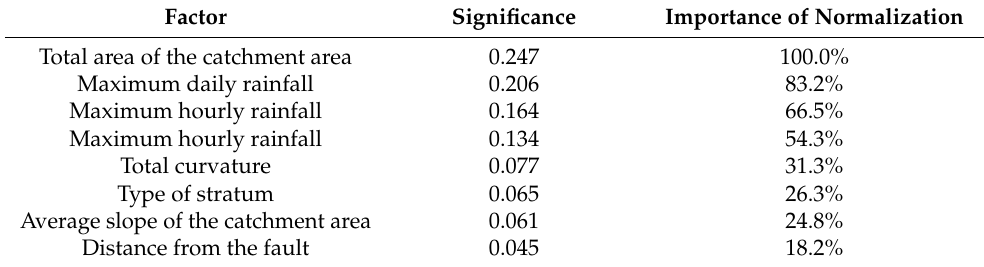
Table 17. Table of coefficients for logistic regression. Factor Significance Importance of Normalization